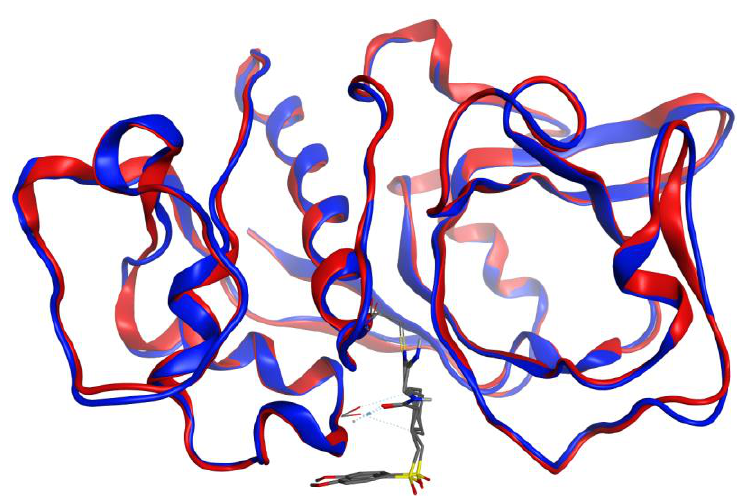
Figure 6. Overlay of the protein structures of rabbit ( Oryctolagus cuniculus ) cathepsin K, PDB 2F7D [25] (red ribbon), and the homology model of Trichomonas vaginalis papain-like protein, TvCP2 (blue ribbon). The co-crystallized ligand is shown as a wireframe structure.